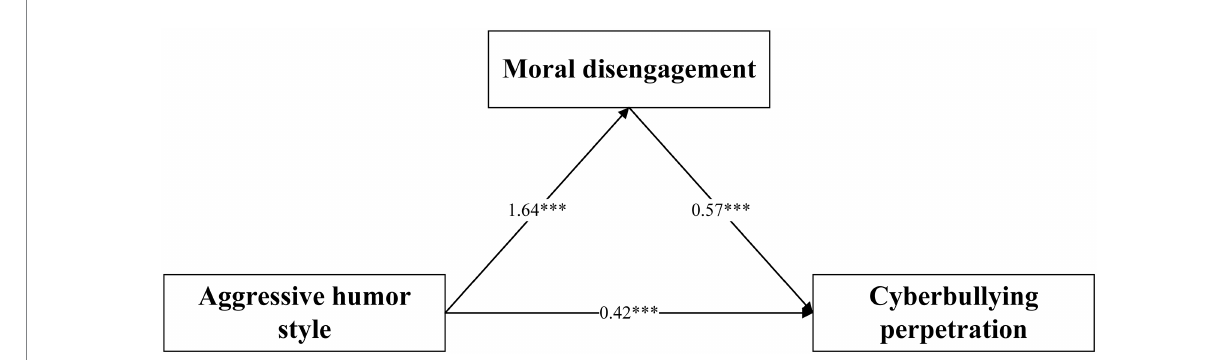
FIGURE 2 Testing for mediation effect. ***Significant at the 0.001 level; Unstandardized betas are reported.